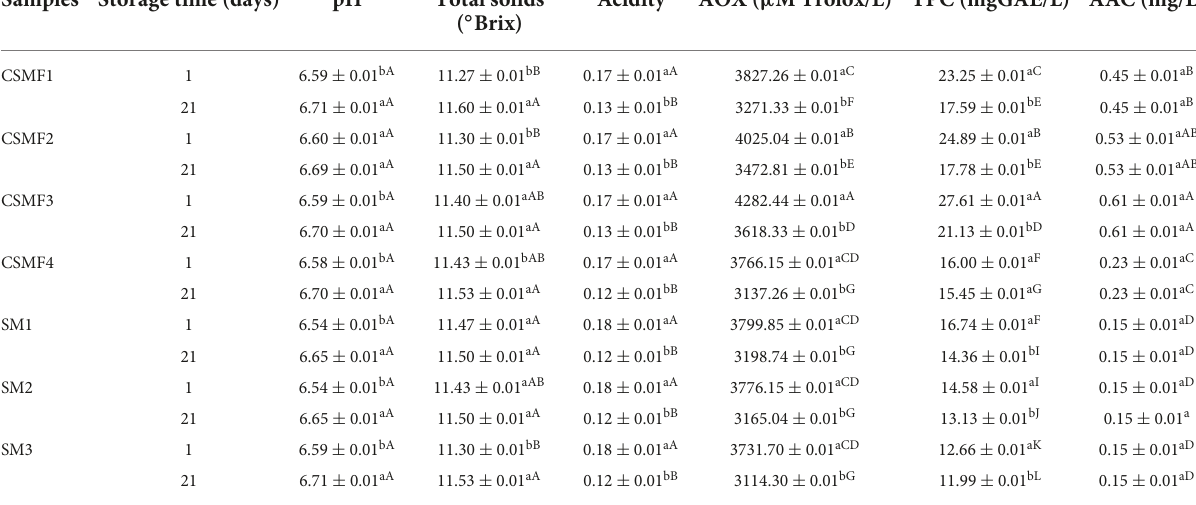
TABLE 1 Effect of cocoa on physicochemical and functional characteristics of the CSMFs at initial (1) and final (21) day of storage. Samples Storage time